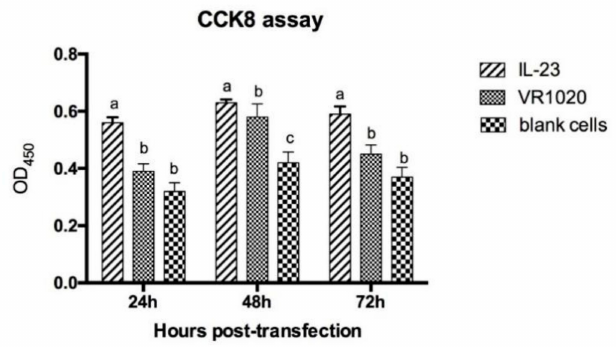
Figure 4. Cell viability assay by CCK8. Di ff erent lowercase letters indicate significant di ff erence among di ff erent groups at the same time, and vice versa. “a, b and c” means that the data of three groups are significantly di ff erent, p <